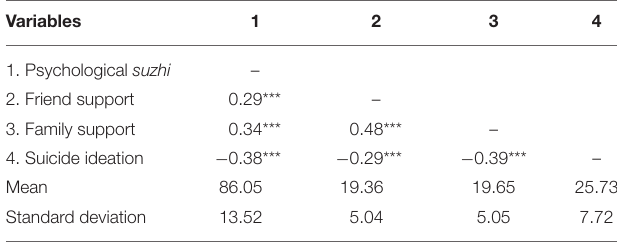
TABLE 1 | Descriptive statistics and bivariate correlations between study